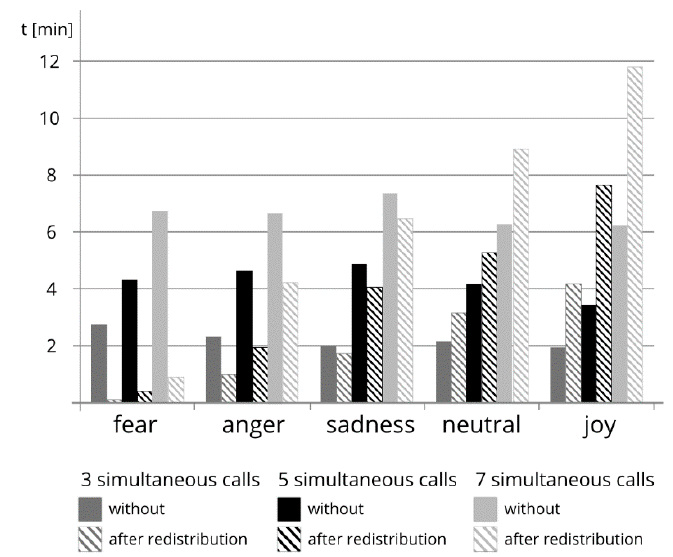
Figure 4. Average waiting time for five emotional states, without and after application of the proposed call redistribution